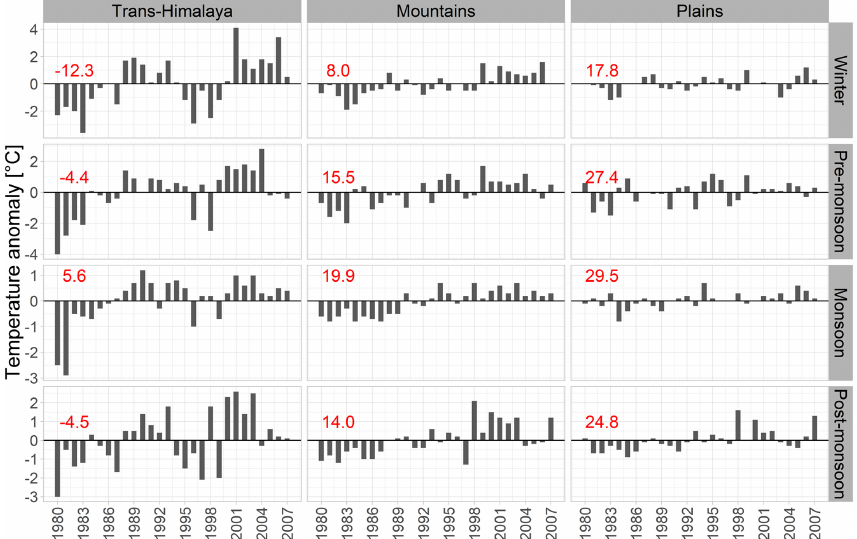
Figure 6. Seasonal temperature anomalies in the KRB (1980–2007). Note: the values in red show the long-term average annual temperature for each